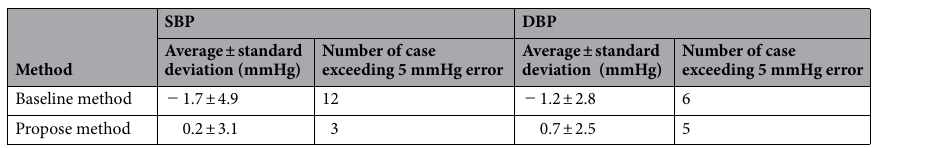
Table 3. Comparison between baseline and proposed